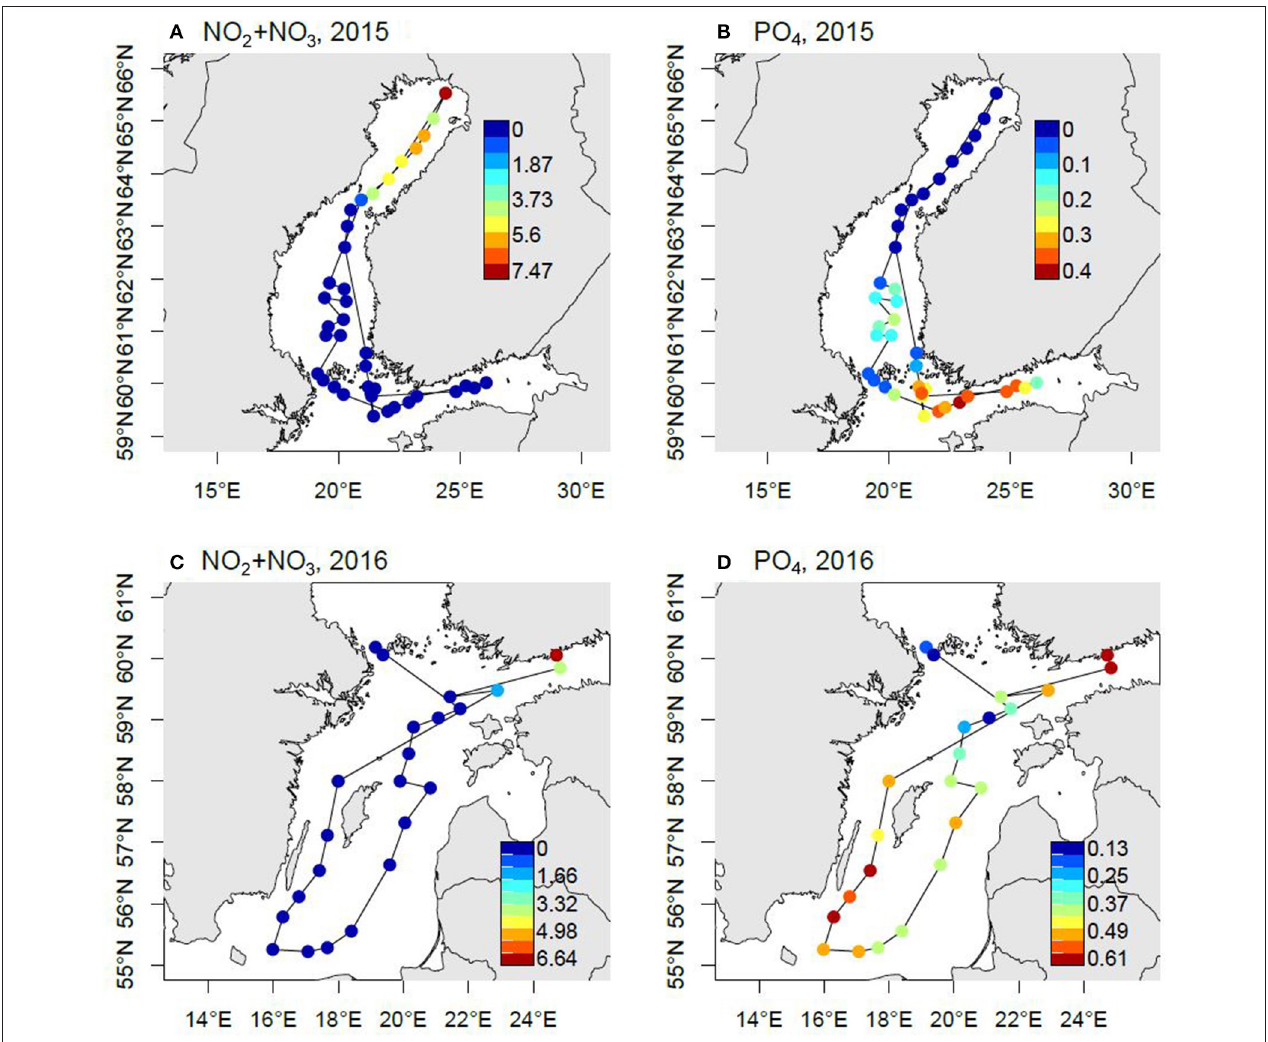
FIGURE 5 | Nutrient concentrations ( µ molL − 1 ) at the surface (3m depth) following the spring bloom. The samples were taken in May 2015 (A,B) and April 2016 (C,D) during the CFLUX15 and CFLUX16 research cruise, respectively, on board R/V Aranda. The maps have been modified from Spilling (2015) and Spilling